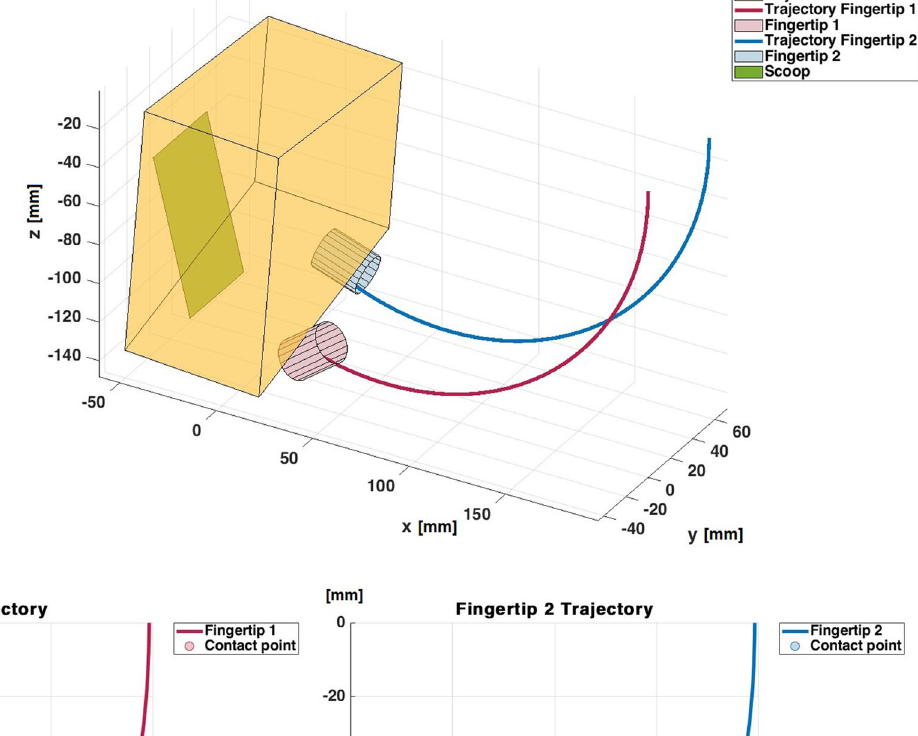
Fig. 7 Position analysis during grasping of an asymmetrical prism